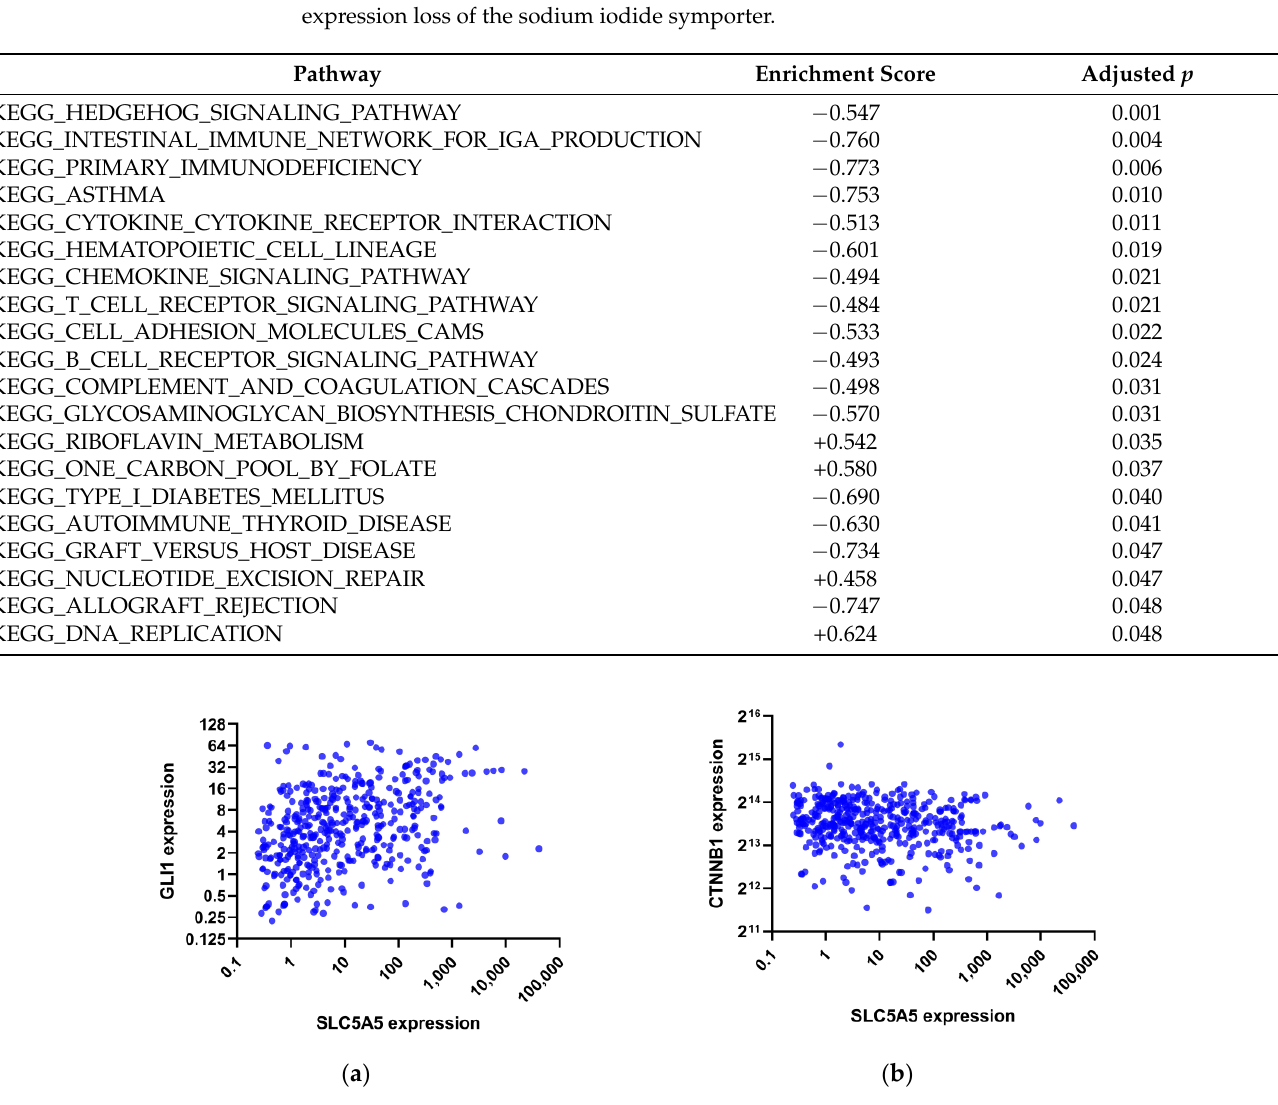
Figure 3. Scatter plots of the expression of SLC5A5 (sodium iodide symporter) versus ( a ) GLI1 expression and (b) CTNNB1 expression in the TCGA-THCA dataset. Table 4. Top 20 Pathway Interaction Database (PID) pathways associated with expression loss of the sodium iodide symporter.